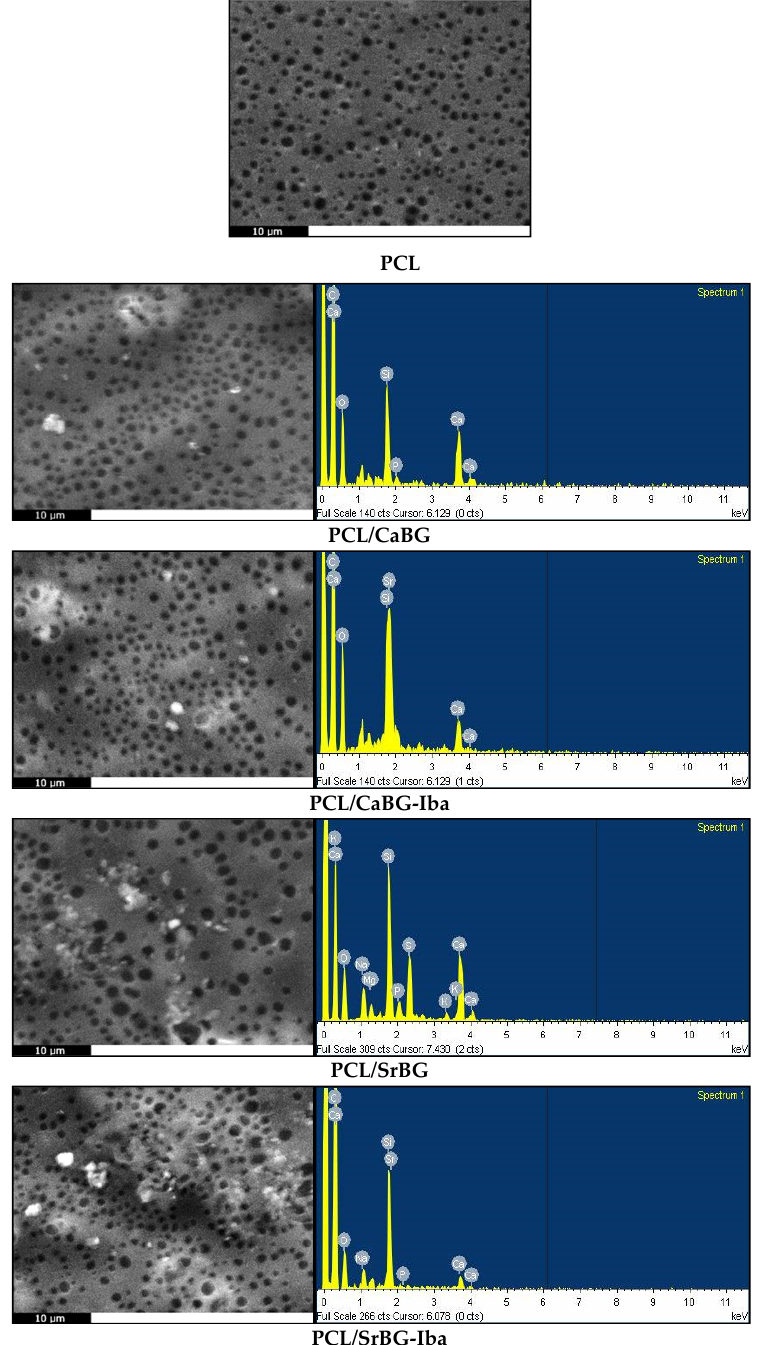
Figure 12. SEM images and EDX spectra of PCL and its composite thins films before and after 14 days of soaking in